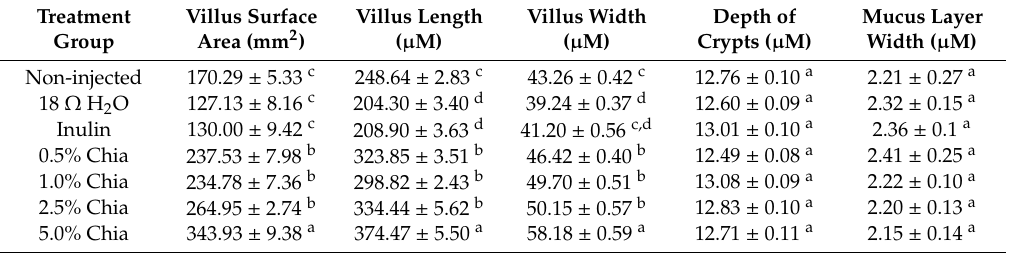
Table 7. E ff ect of the intra-amniotic administration of experimental solutions on the duodenal small intestinal villus and crypt.